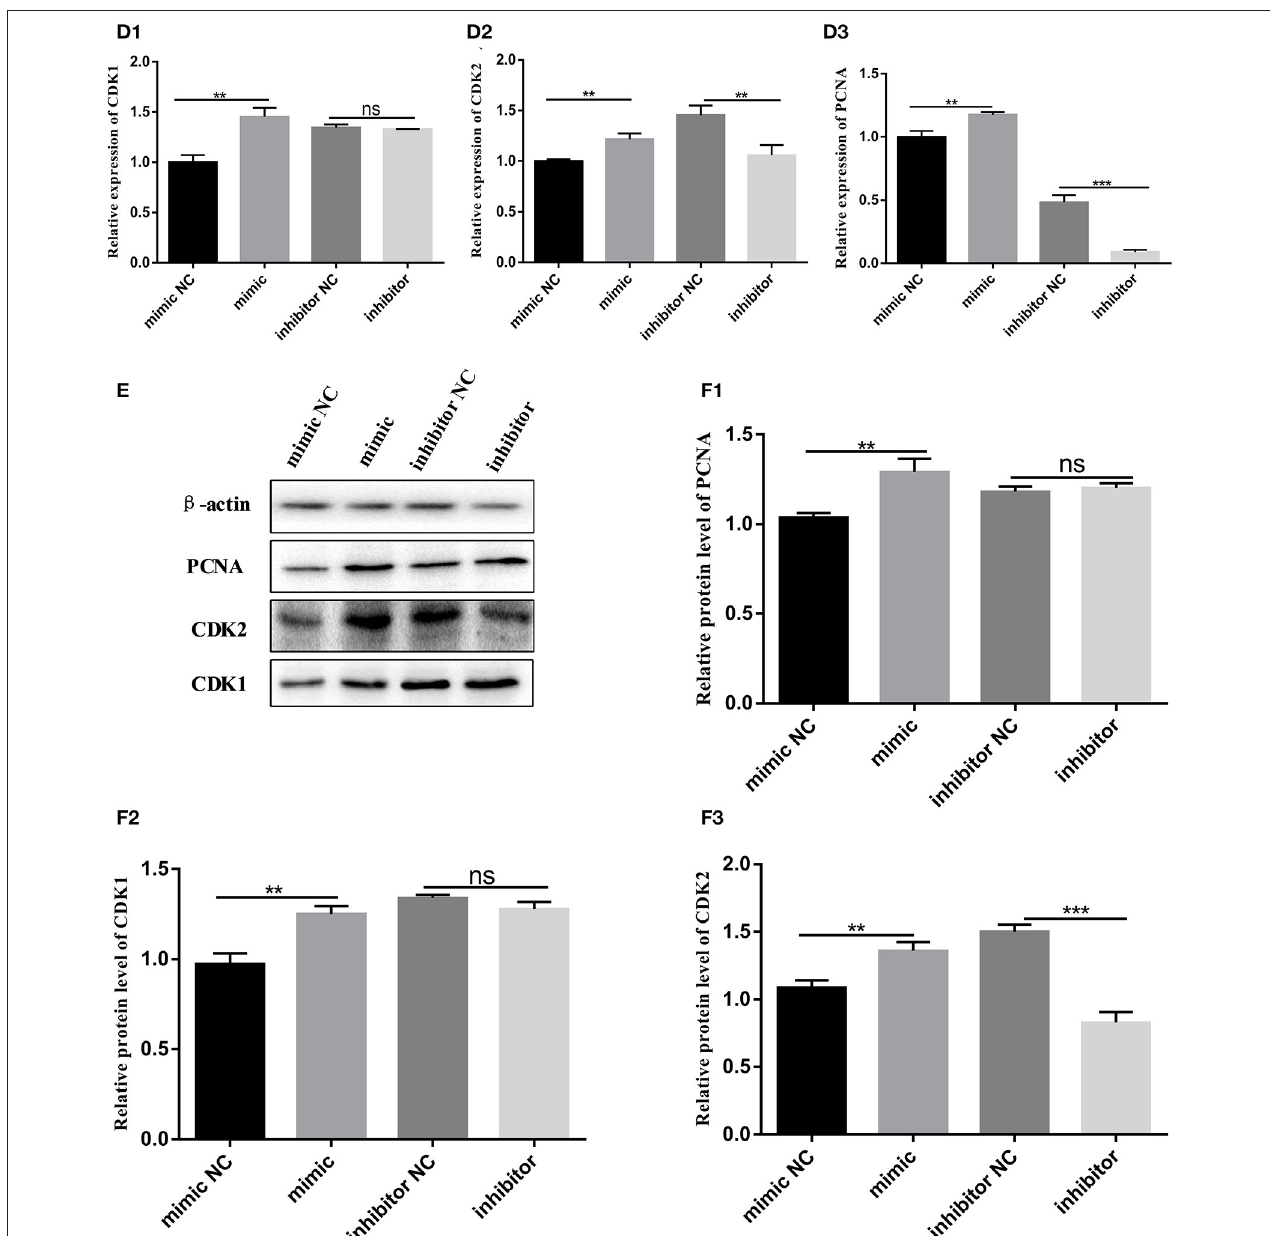
FIGURE 2 | Proliferation of Qinchuan bovine pre-adipocytes is promoted by bta-miR-150. (A,B) Bovine adipocytes transfected with mimic, mimic NC, inhibitor, and inhibitor NC. Cells harvested at 48h after transfection were stained red with EdU (to indicate DNA replication) and blue with Hoechst (cell nuclei) (C) CCK-8 assays of bovine adipocytes. After incubating with 10% CCK-8 for 4h, absorbance was measured at a wavelength of 450nm. (D1–D3) Changes in mRNA levels of proliferation-related target genes according to qPCR findings. (E, F1–F3) Proliferation-related protein quantitation according to western blot findings. Error bars represent mean ± SD. N = 3 replicates. *Significantly different; * p < 0.05, ** p < 0.01, *** p < 0.001, Student t -tests.